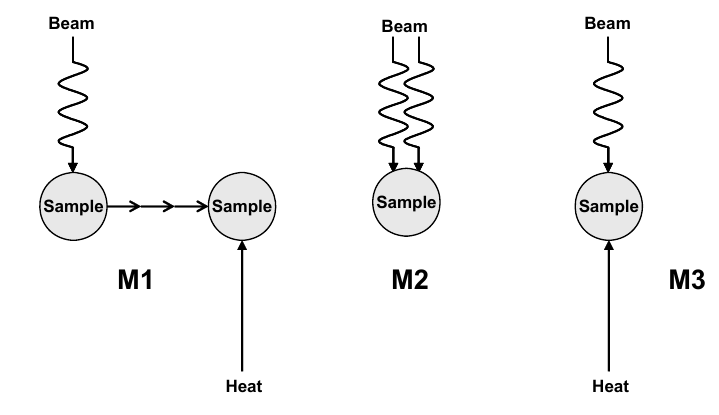
Figure 1. Combinations of electron-beam treatment and heating.